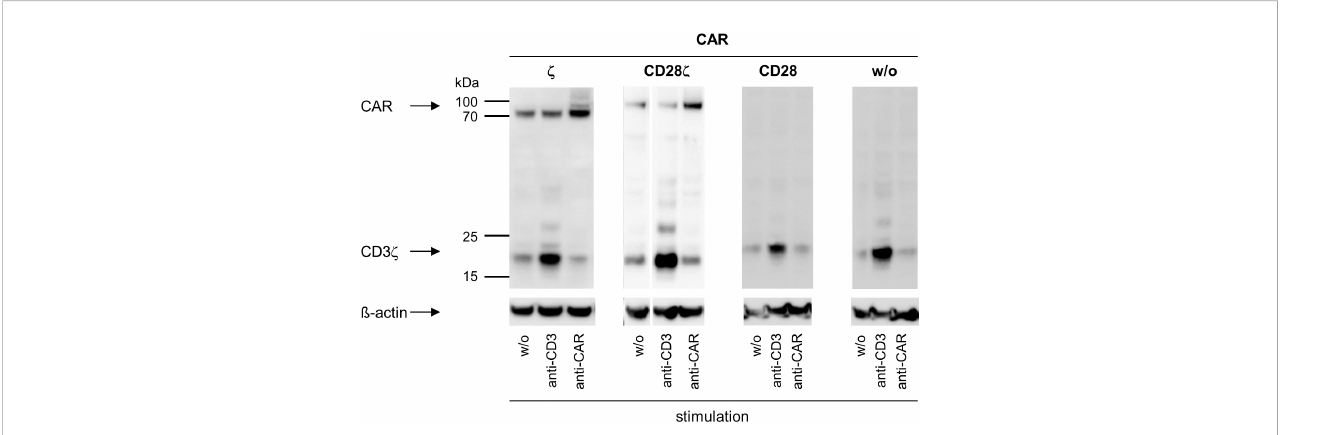
FIGURE 3 z CARs and TCR/CD3 do not cross-activate through their CD3 z chains. CAR engineered Jurkat cells were recorded for CD3 z phosphorylation by Western blot analysis. Non-modi fi ed (w/o) Jurkat cells or Jurkat cells engineered with z CAR, CD28 CAR or CD28 z CAR (5 x 10 6 cells each) were subjected stimulation through their TCR by incubation with the agonistic mouse anti − CD3 antibody OKT3 (10 m g/ml) for 10 min followed by an anti − mouse IgG antibody (10 m g/ml) for cross-linking for 3 min ( z CAR, CD28 CAR and w/o CAR) or 1 min (CD28 z CAR). Alternatively, cells were stimulated through the CAR independently of the binding domain by incubation with a goat anti − human IgG antibody (10 m g/ml) for 10 min followed by an anti − goat IgG antibody (10 m g/ml) for cross-linking for 3 min ( z CAR, CD28 CAR and w/o CAR) or 1 min (CD28 z CAR). Lysates were separated by SDS PAGE and blotted membranes were probed with the anti − phospho-CD247 (CD3 z ) (Tyr142) antibody (clone EM-54) (1:1,000) followed by a peroxidase- conjugated anti − mouse IgG1 antibody (1:10,000) for detection. Blots were re-probed with an anti − human b -actin antibody